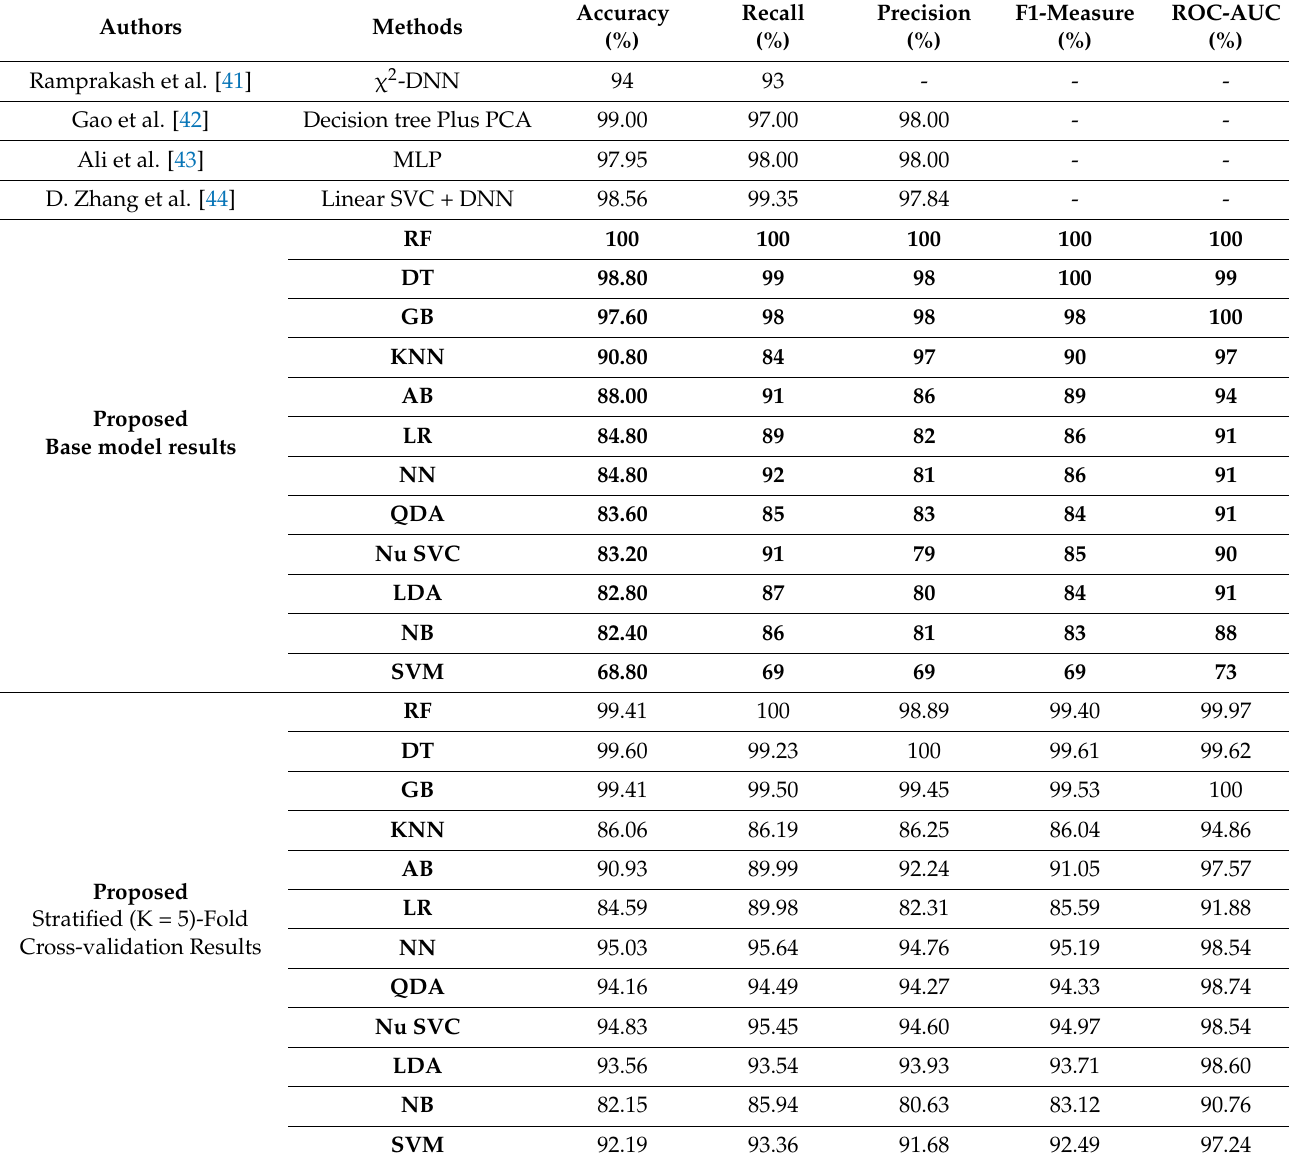
Table 5. Comparative study of the proposed method with existing